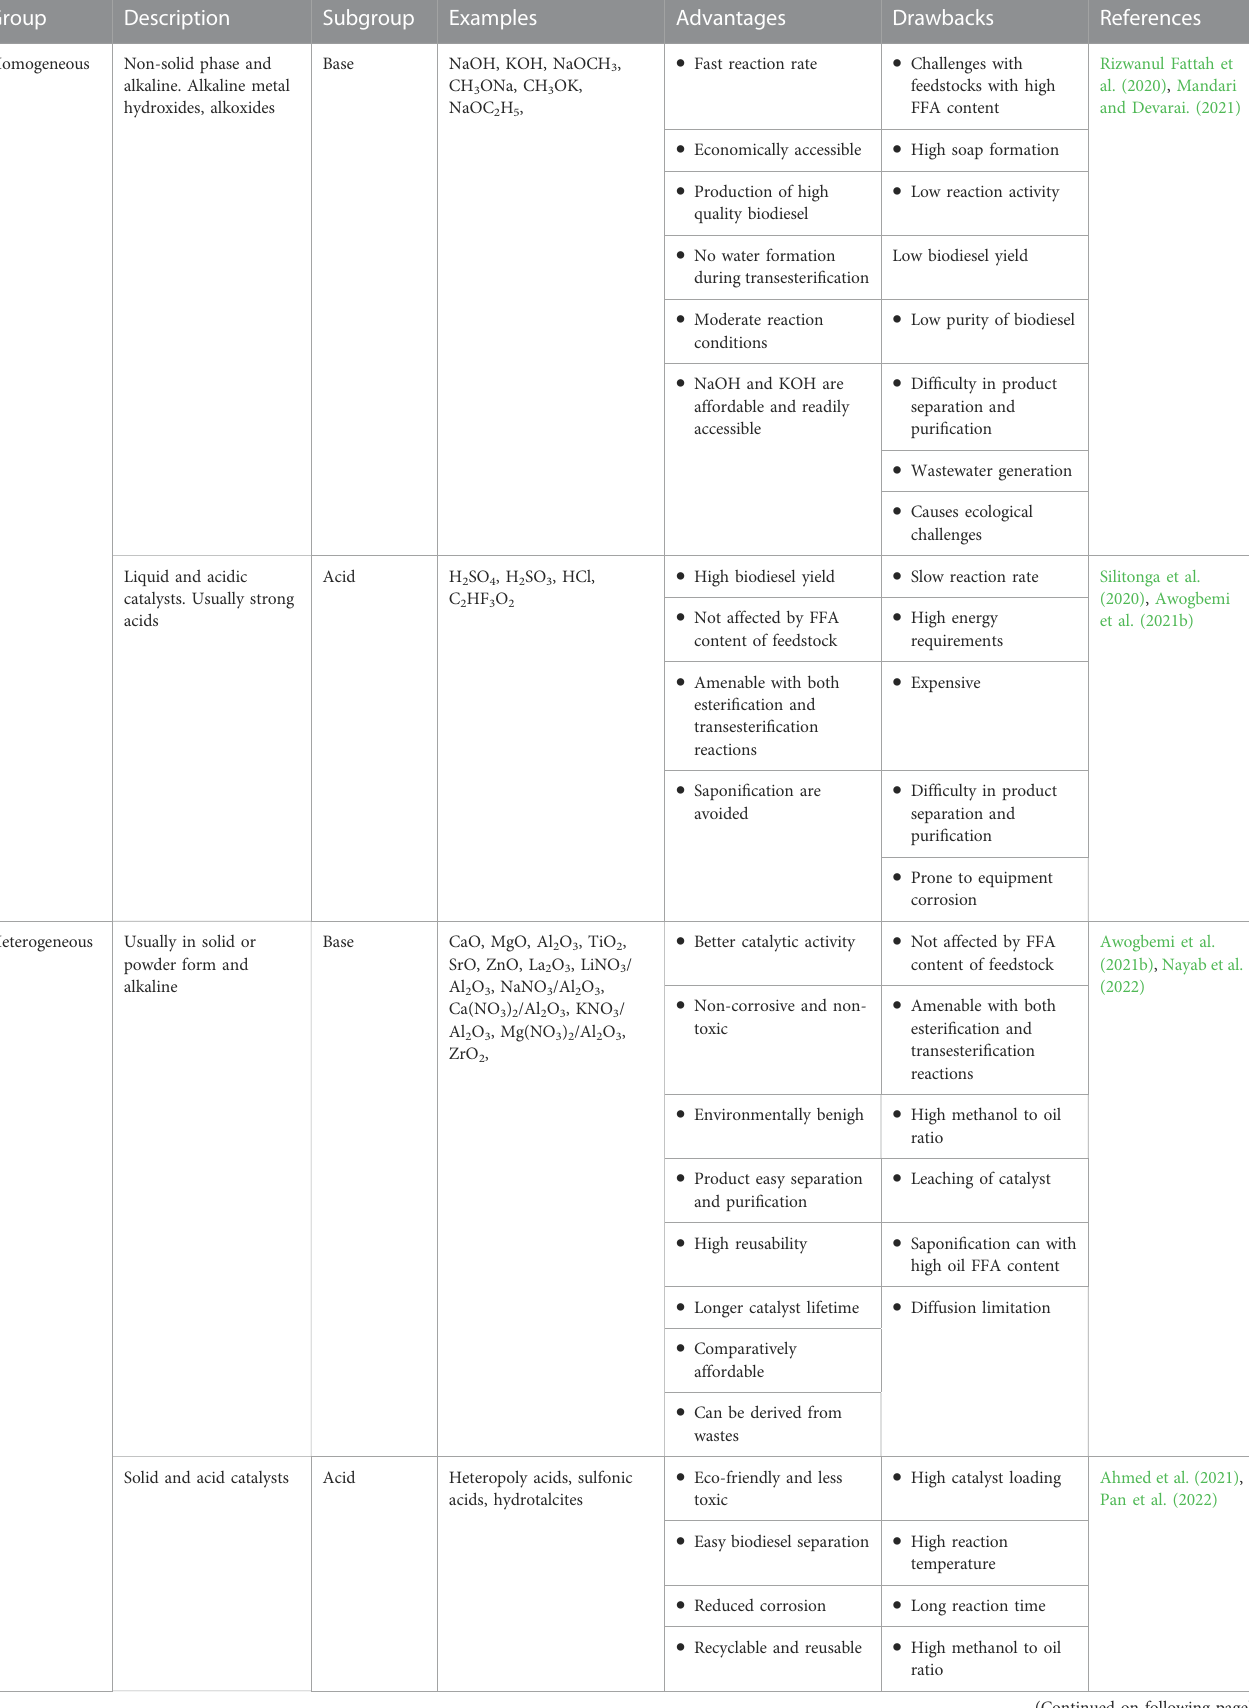
TABLE 2 Examples, advantages, and drawbacks of classes of catalysts for biodiesel